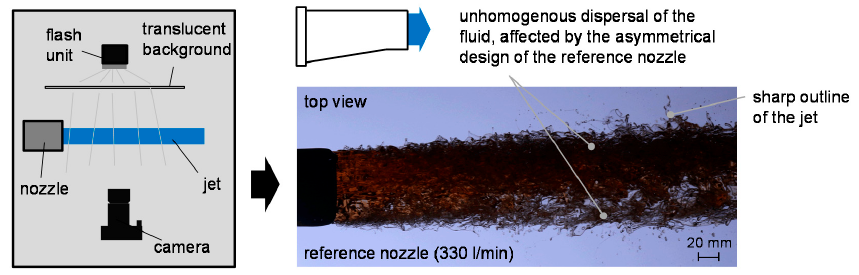
Figure 3. Measurement setup for high-speed photography.